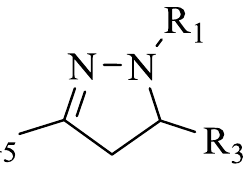
Figure 1. The general structure of the pyrazoline at position 1-, 3- and 5-.